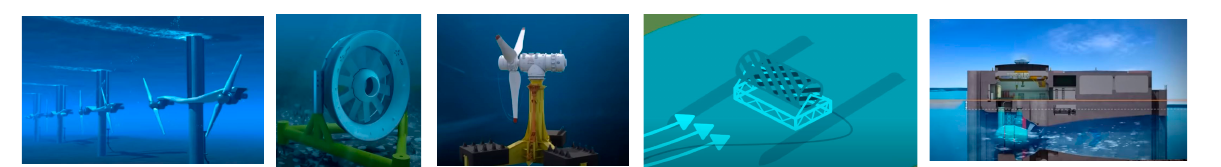
Figure 28. Tidal reservoir installation [66].